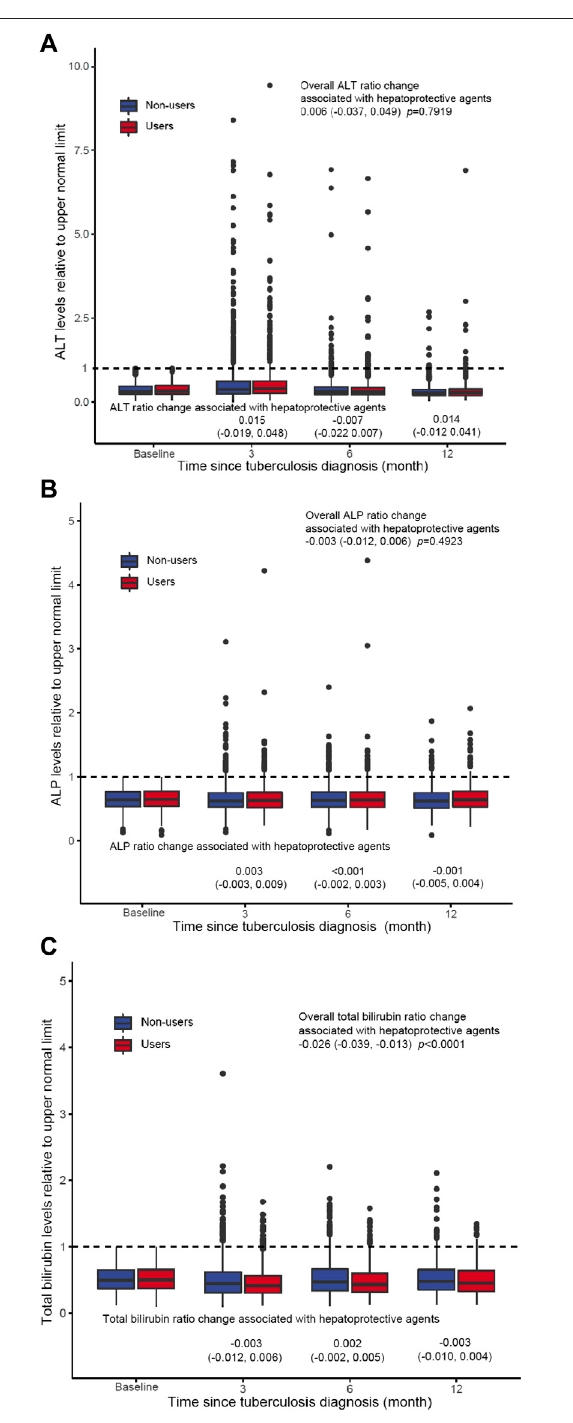
FIGURE 2 | ALT (A) , ALP (B) , and total bilirubin (C) trajectories during follow-up. Estimated laboratory values and 95% CI at baseline for 90, 180 days, and 1 year were plotted for the hepatoprotective agent users and non-users. Laboratory test value changes associated with liver- protectiveagentutilizationateachtimepointrepresentthedifferencebetween the two trajectories in which the non-user (unexposed) group served as a